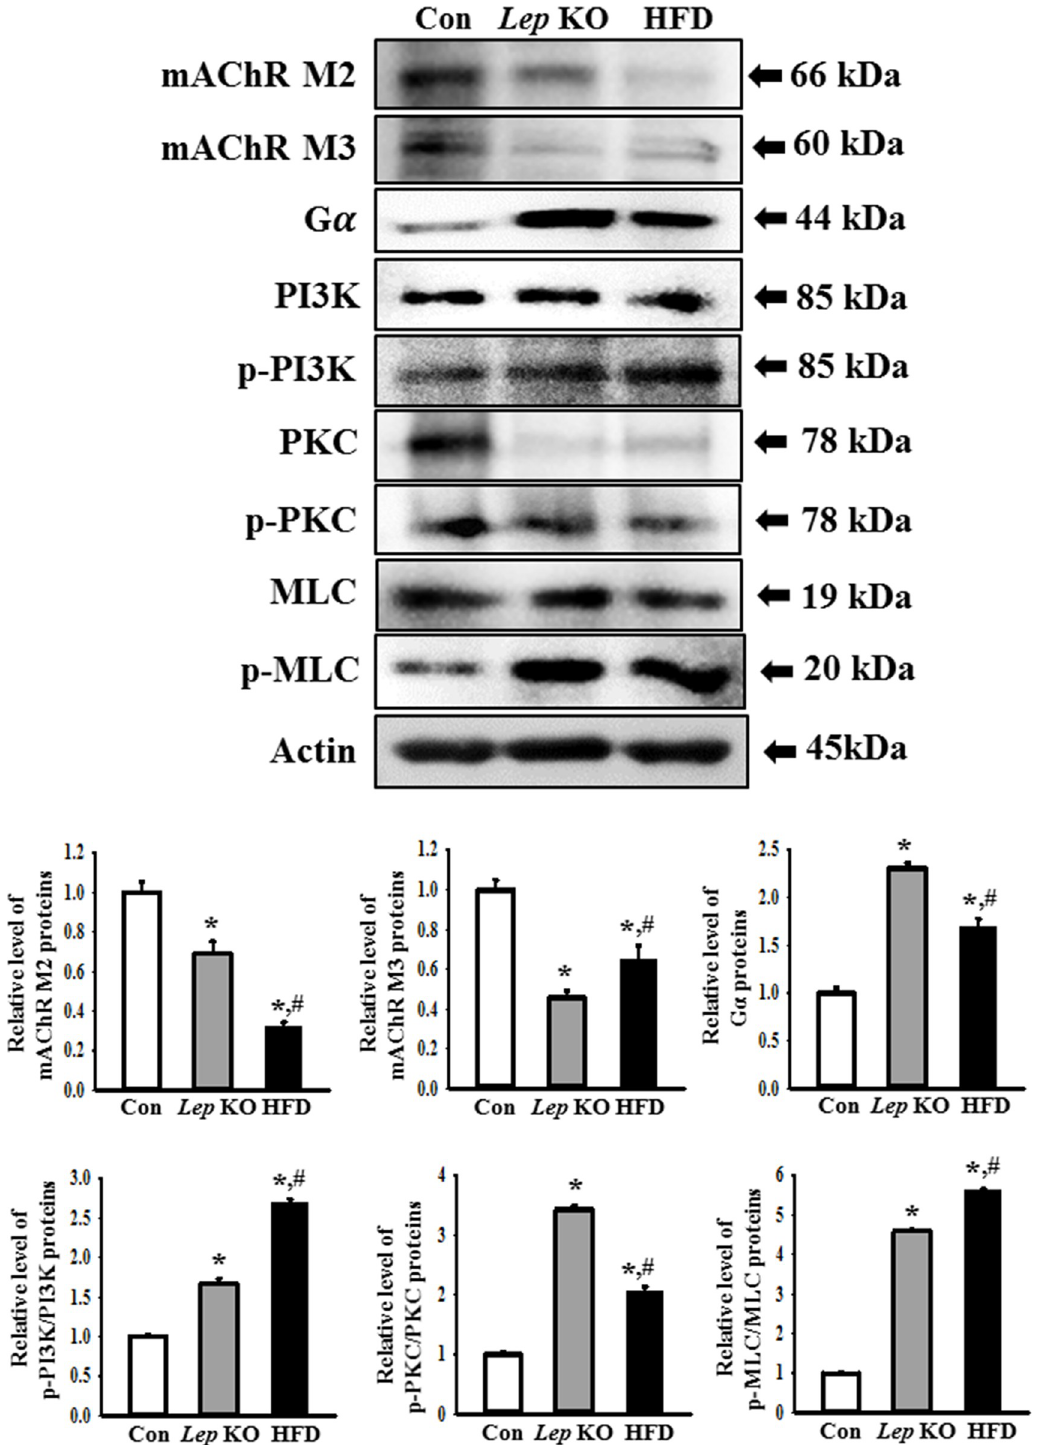
Fig 8. Expression of mAChRs proteins and the key mediators within their downstream signaling pathway. Expression levels of mAChR M2/M3 and the key mediators, including G α , PKC, p-PKC, PI3K, p-PI3K, MLC, and p-MLC were measured by Western blot analysis using the specific primary antibodies and HRP-labeled anti-rabbit IgG antibody. The intensity of each lane for a specific protein was calculated based on the intensity of β -actin. Three to five mices per group were used to prepare the total tissue homogenate, and Western blot analyses were assayed in duplicate in each sample. The data are reported as the mean ±